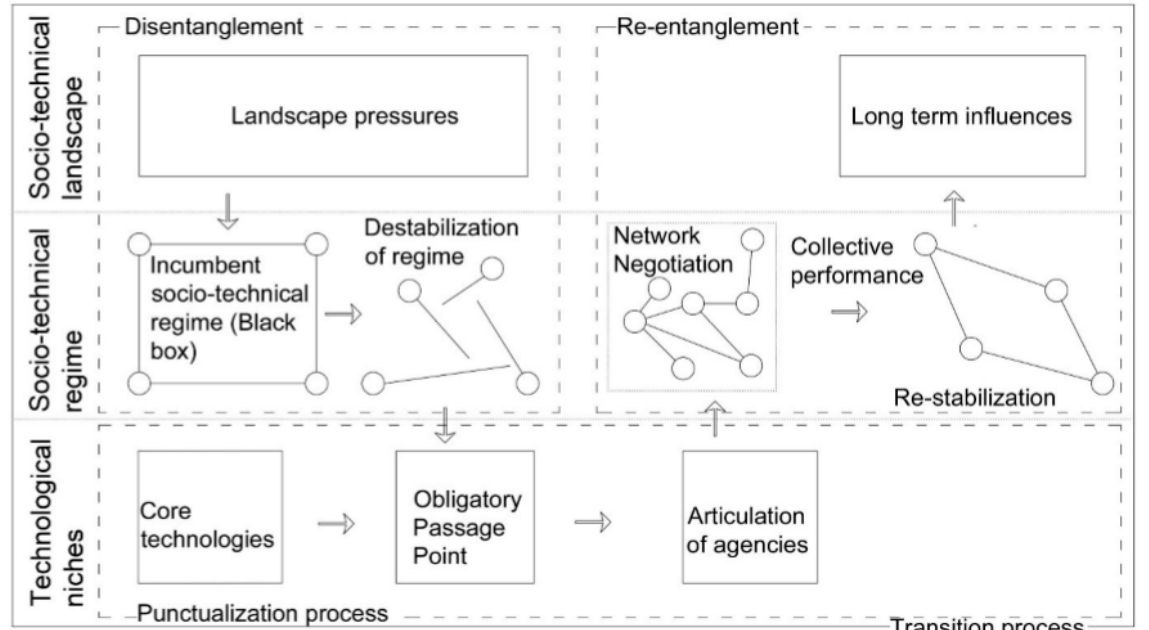
Figure 1. Translation of transition steps [19] (p. 31).